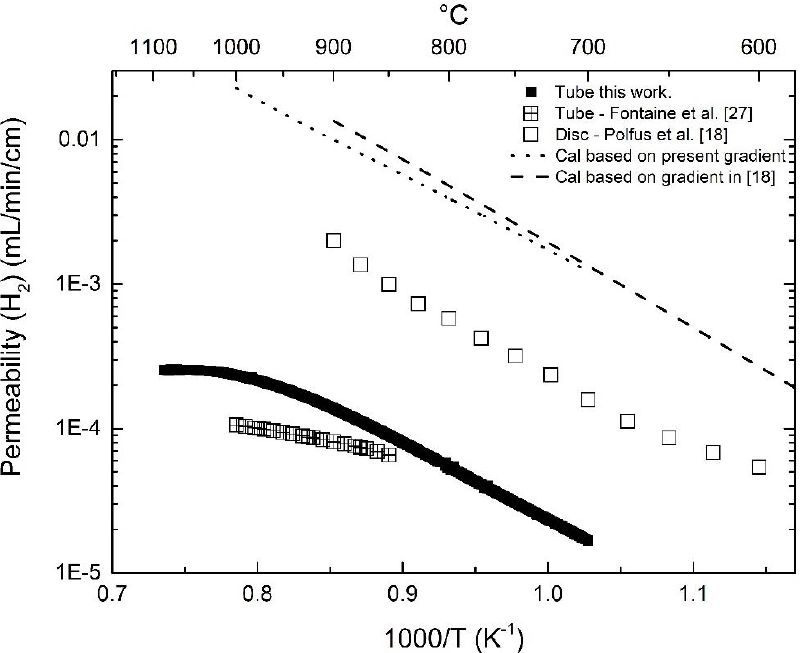
Figure 5. Comparison of hydrogen permeability between experimental values and calculated from the ambipolar conductivity of LSC.